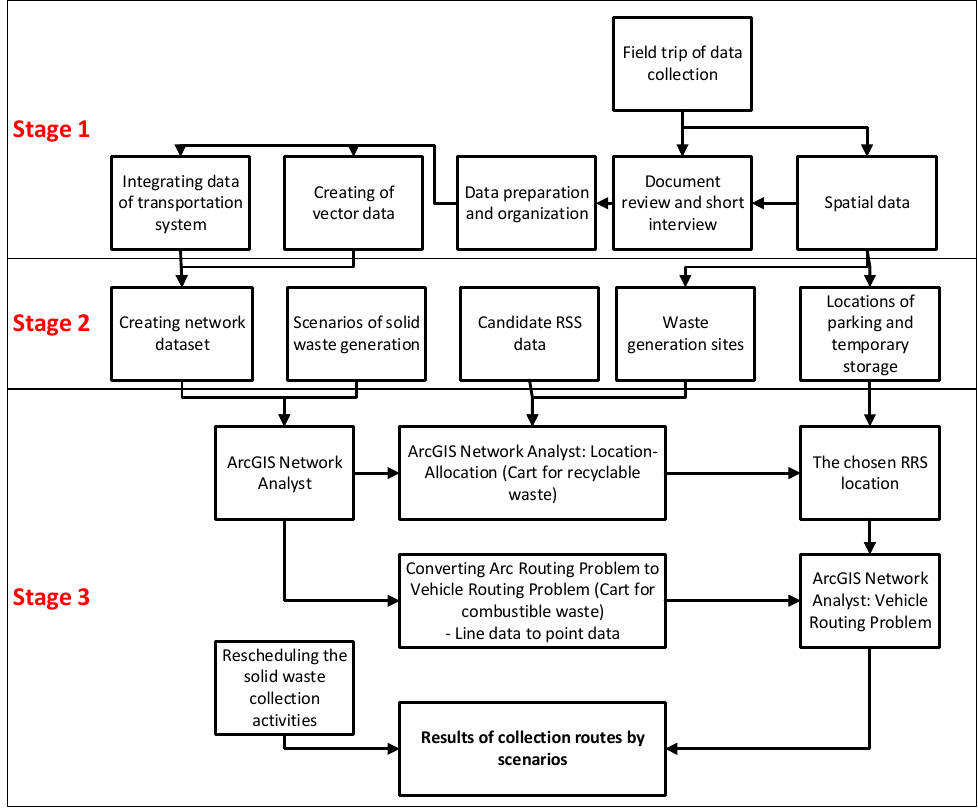
Fig. 5: The process of method applied